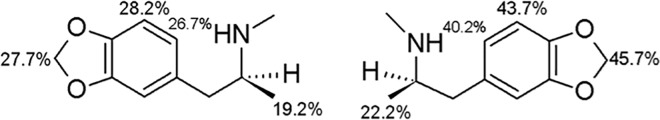
The structures of MDMA enantiomers with the percentage of signals intensity as obtained from the STD experiments.The first structure corresponds to the (S)-MDMA and the second to (R)-MDMA.